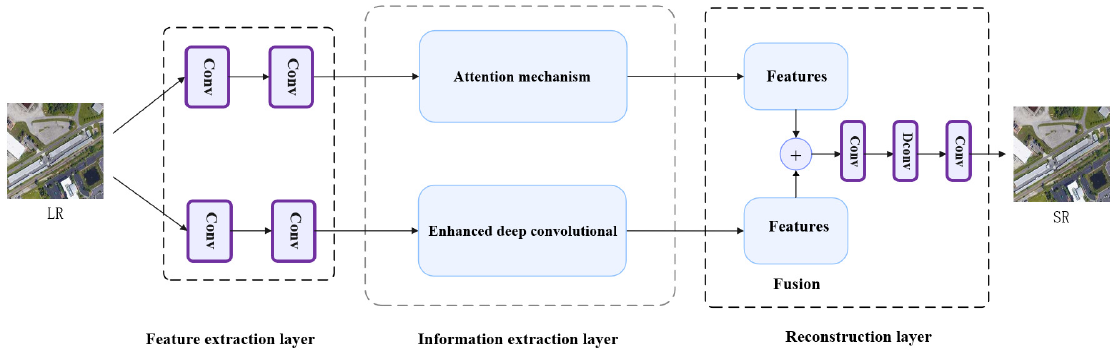
Figure 6. The architecture of the generator network.